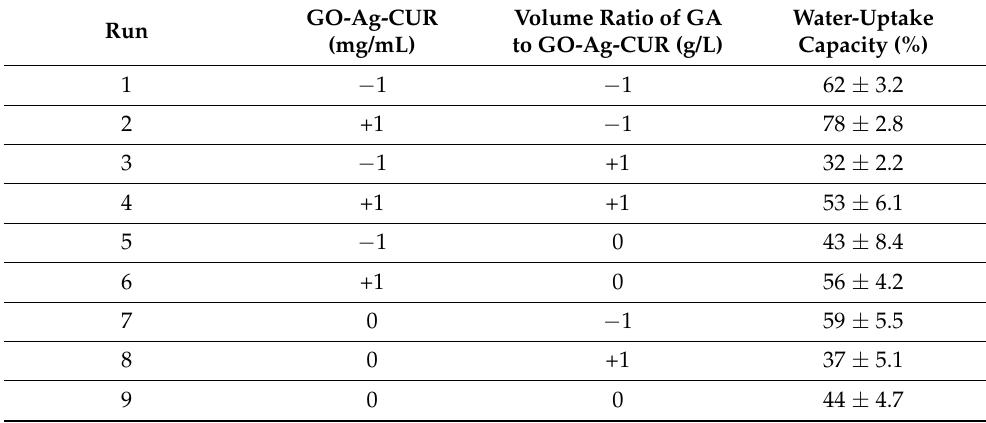
Table 1. Matrix of CCD; factors and experimental